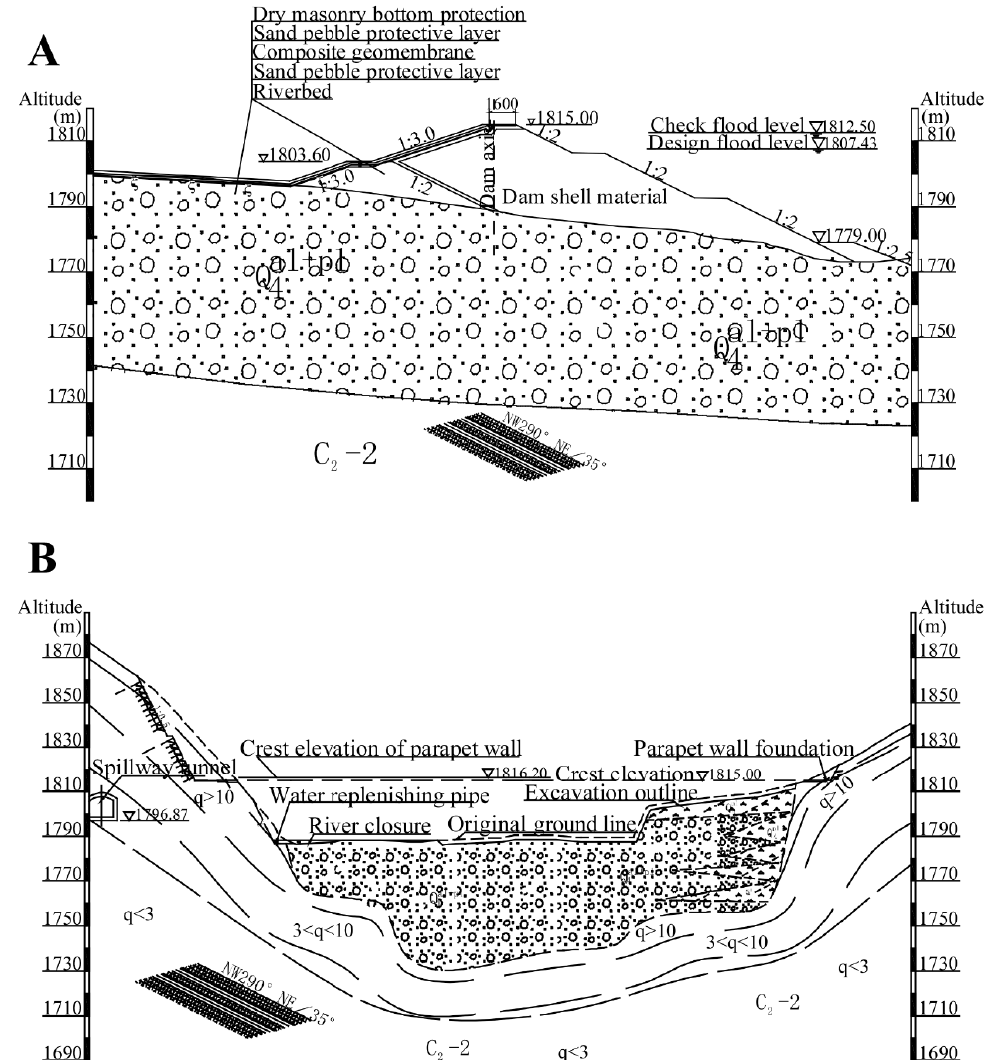
Figure 3. Sections of the embankment dam for sediment storage: ( A ) a typical cross section; ( B ) the dam axis section.